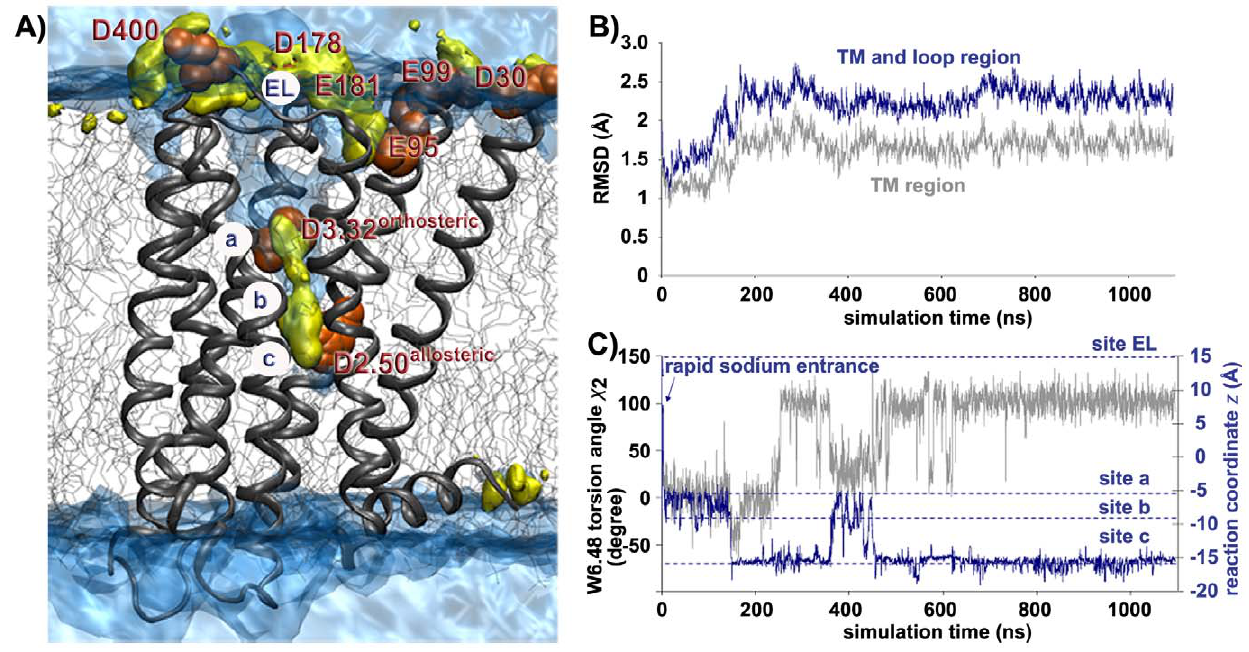
Figure 1. Sodium ion’s pathway into the D 2 receptor, receptor stability, and conformational change of the toggle switch Trp 6.48. (A) Volumetric map of sodium ions (yellow isosurface) within the D 2 receptor at chemical potential m = 2 4k B T relative to the bulk concentration of 150 mM NaCl showing the sodium ions binding sites. The ions move from the extracellular loop (EL) along negatively charged residues (orange spheres) towards the receptor interior (sites a to c ) as computed from the ion concentration over 4.7 m s (MD2) of data. The volumetric map of water (blue isosurface) computed at m = 2 0.5k B T relative to bulk water illustrates that part of the receptor interior is filled with water molecules including sites a , b and c . (B) The RMSD of the D 2 receptor model embedded in a hydrated lipid bilayer over MD1; grey line: TM region, blue line: whole receptor including TM and loop region. (C) Depiction of the sodium ion’s reaction coordinate z (blue line) and the Trp6.48 torsion angle x 2 , (grey line) over MD1. Sodium transition from Asp3.32 (site a ) to Asp2.50 (site c ) induces a conformational change of the Trp6.48 rotamer